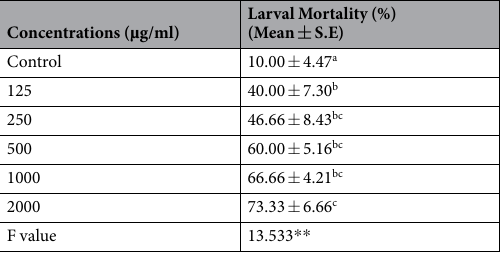
Table 2. Mortality of S. litura larvae fed on diet supplemented with different concentrations of ethyl acetate extract of S. commune . The values are mean ± standard error. Significance ascribed as * p < 0.05 and ** p < 0.01 (One way ANOVA). Different letters a, b, c within the column are significantly different (Tukey’s test, p ≤ 0.05) and signify the effect of concentration.